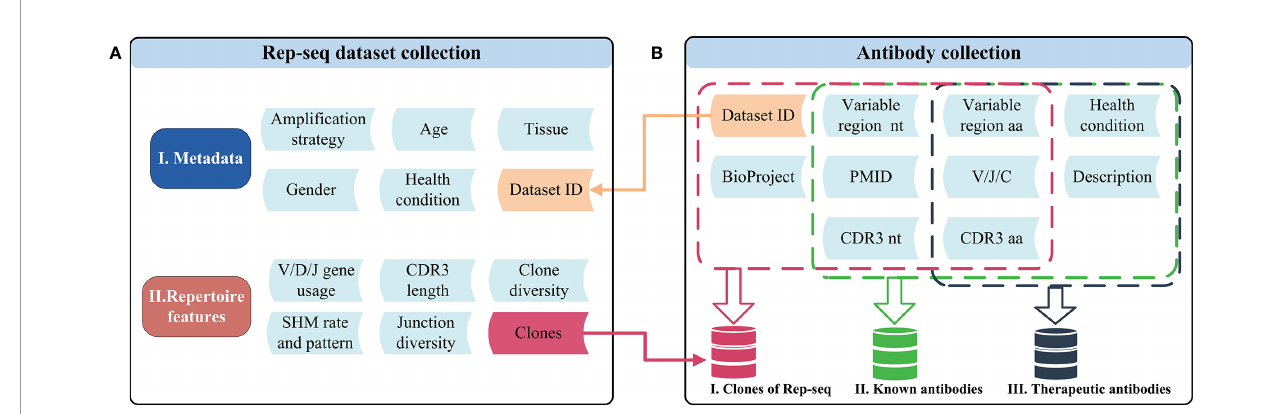
FIGURE 1 | Schematic of the datasets and related features in RAPID. (A) Rep-seq datasets and their metadata (top) and repertoire (bottom) features. Metadata is linked with “ Dataset ID ” and can be obtained by it. The “ Clones ” in repertoire features was generated after the process of RAPID pipeline (Materials and Methods). (B) The antibody collections included in RAPID consist of three data sources: Rep-seq datasets, known antibodies, and therapeutic antibodies. All available information was extracted from these sources and stored. In addition, antibody sequences were analysed, and related information (such as VDJ gene usage and CDR3) were extracted and recorded. nt, nucleotide; aa, amino